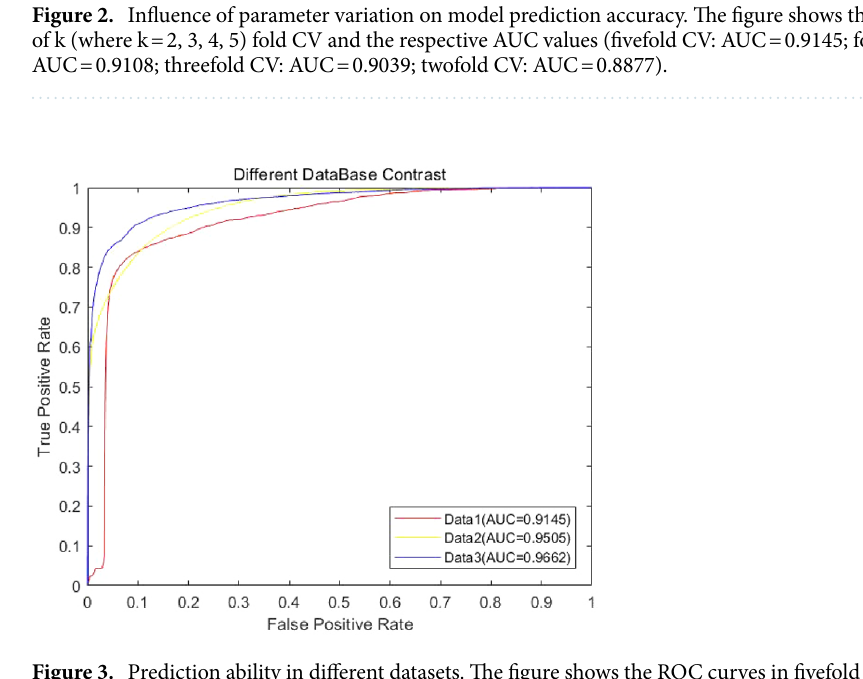
Figure 3. Prediction ability in different datasets. The figure shows the ROC curves in fivefold CV and the AUC values (Data 1: AUC = 0.9145; Data 2: AUC = 0.9505; Data 3: AUC =